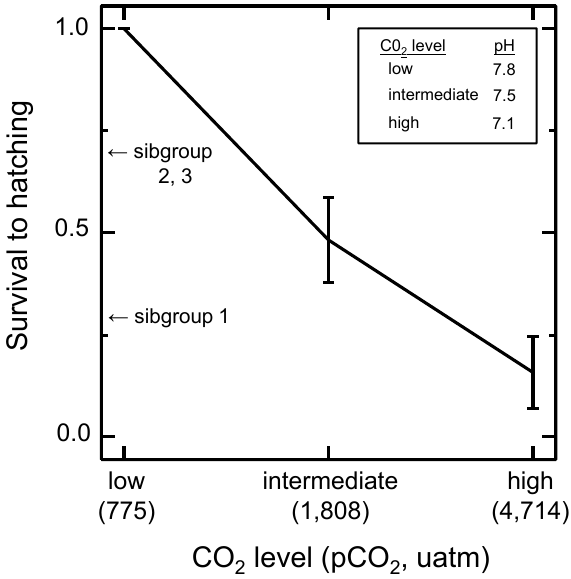
Fig. 2. Proportion of fertilized eggs of summer flounder surviving to hatching at different levels of CO 2 in rearing water (inset: asso- ciated pH values). Embryos were obtained from three females each crossed with milt pooled from three to five males. Mean ( ± SE) rela- tive survival is plotted where survival data for each female sibgroup were first scaled to sibgroup survival at ambient (low) CO 2 (i.e., rel- ative survival at low CO 2 = 1 . 0 for all sibgroups). Absolute survival at ambient conditions for each sibgroup is denoted by